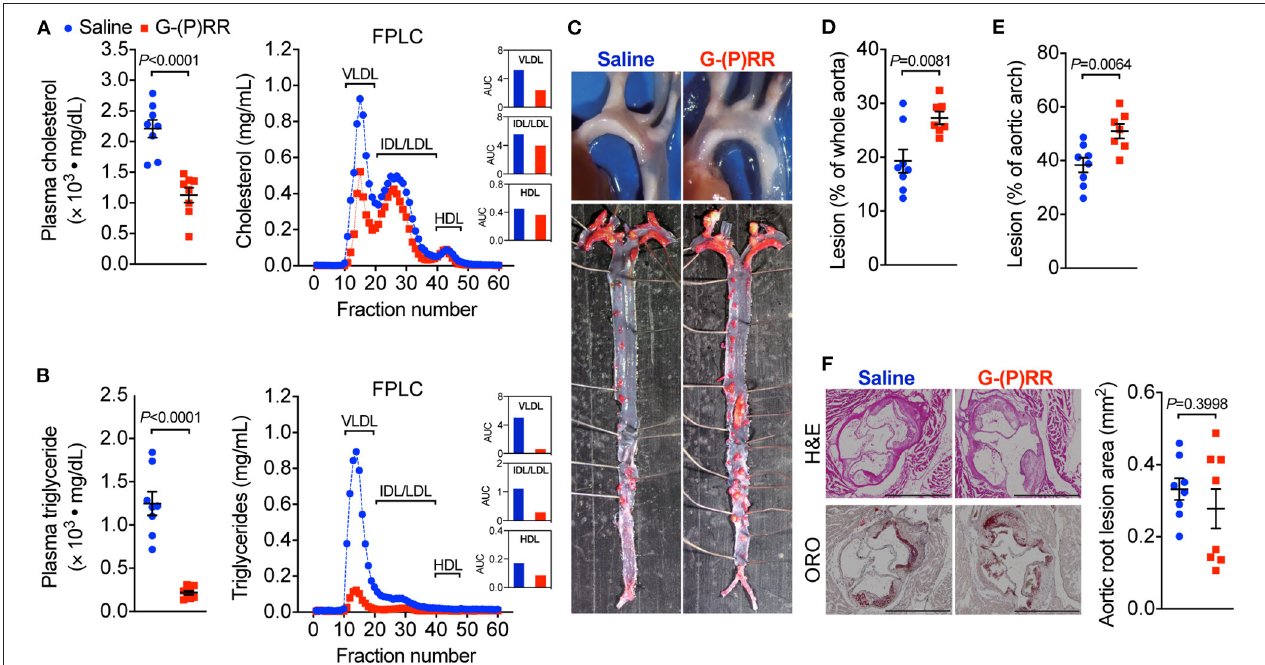
FIGURE 1 | (Pro)renin receptor [(P)RR] N-acetylgalactosamine-modified antisense oligonucleotides (G-ASOs) reduced plasma cholesterol and triglyceride concentrations but not atherosclerosis in low-density lipoprotein receptor deficient (LDLR − / − ) mice fed a western-type diet (WTD). Eight-week-old male LDLR − / − mice were administered with saline (blue) or (P)RR G-ASOs (red) and fed a WTD for 16 weeks. N = 8/group. Total plasma cholesterol (A) and triglycerides concentrations (B) . Pooled plasma samples were resolved by FPLC for lipoprotein fractionation analysis, and cholesterol (A) and triglycerides content (B) in each fraction was determined . Representative images of the aorta arch and Oil Red O-stained whole aorta (C) . Quantification of lesion areas of the whole aorta (D) and aortic arch region (E) . Representative images of cross-sectioned aortic root stained with H&E and ORO and quantification of lesion areas of the aortic root (F) . Bar = 1,000 µ